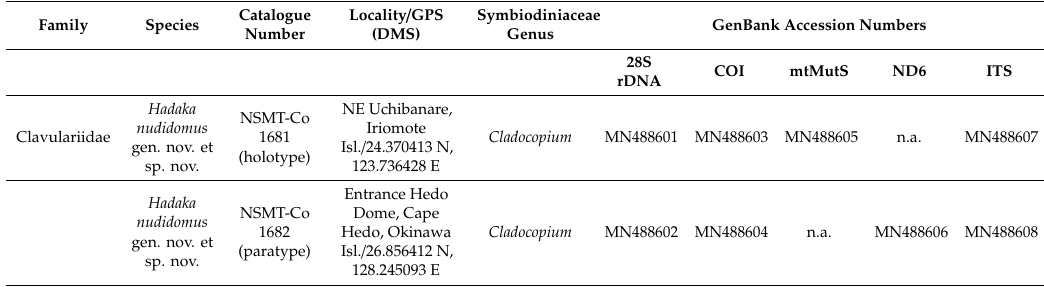
Table 1. Overview of information on octocoral specimens collected from mesophotic coral reef ecosystems (MCEs) at Iriomote and Okinawa Islands, Okinawa Prefecture, Japan, including GenBank accession numbers and locality. Catalogue number: NSMT = National Museum of Nature and Science, Tokyo, Japan; n.a. = not